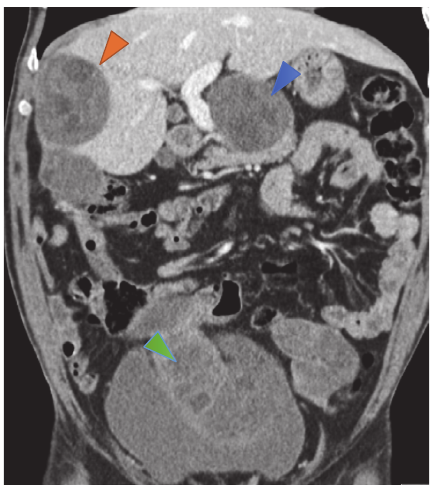
Figure 1: Coronal contrast enhanced CT image shows multiple abdominal hypodense lesions within liver (orange arrowhead) and lesser omentum (blue arrowhead) and peritoneum and above the bladder (green arrowhead).